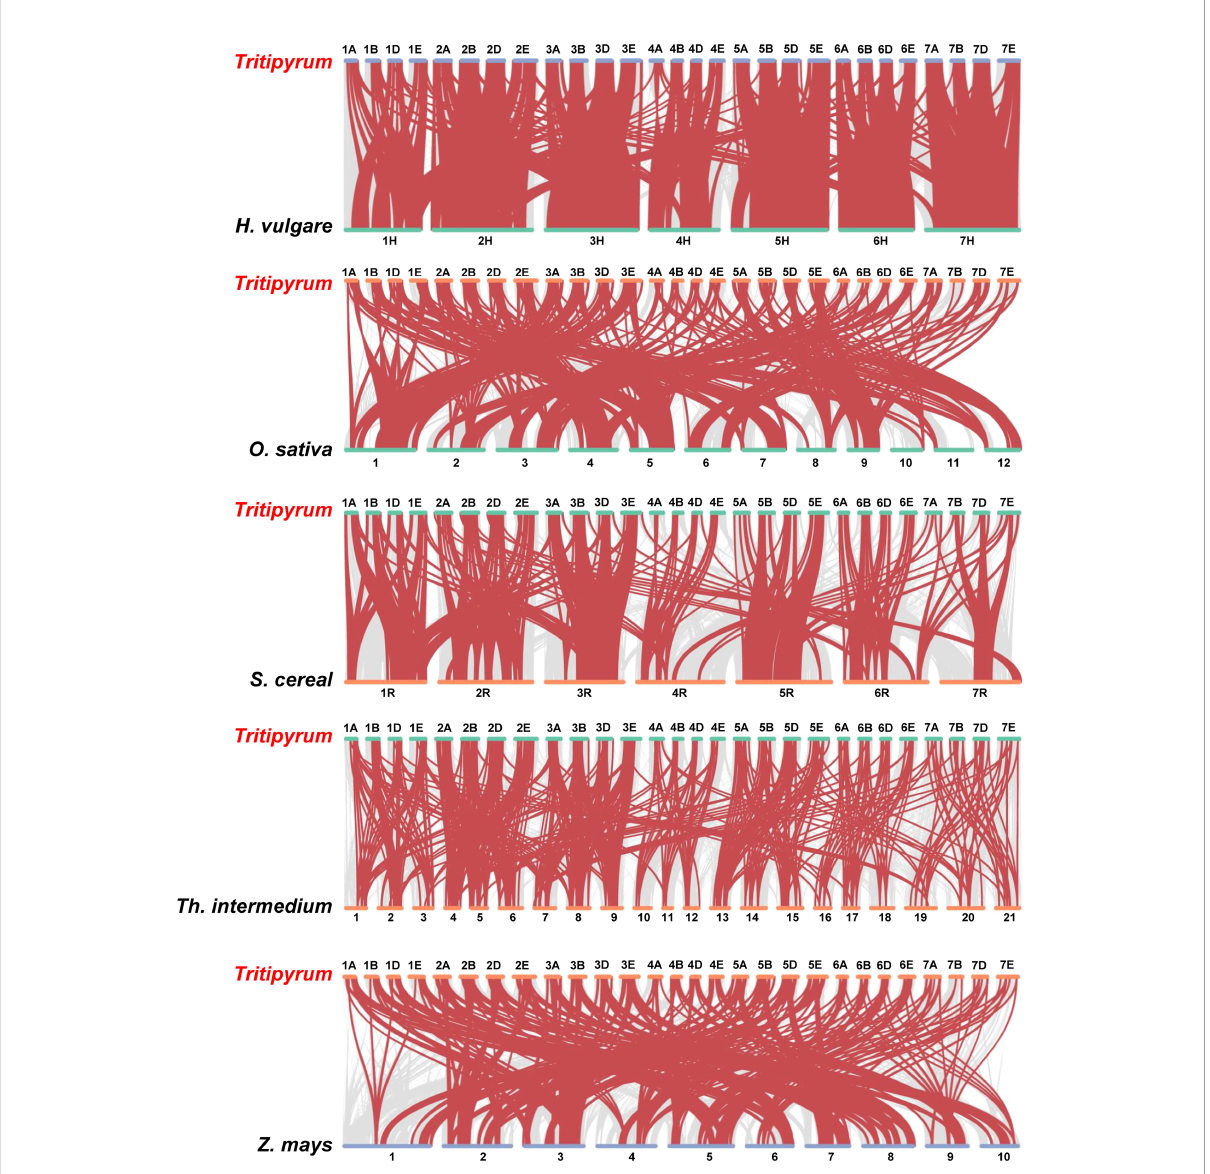
FIGURE 4 Synteny analyses between Tritipyrum and fi ve representative plant species. Gray lines in the background indicate collinear blocks within Tritipyrum and other plant genomes, while red lines highlight syntenic WRKY gene